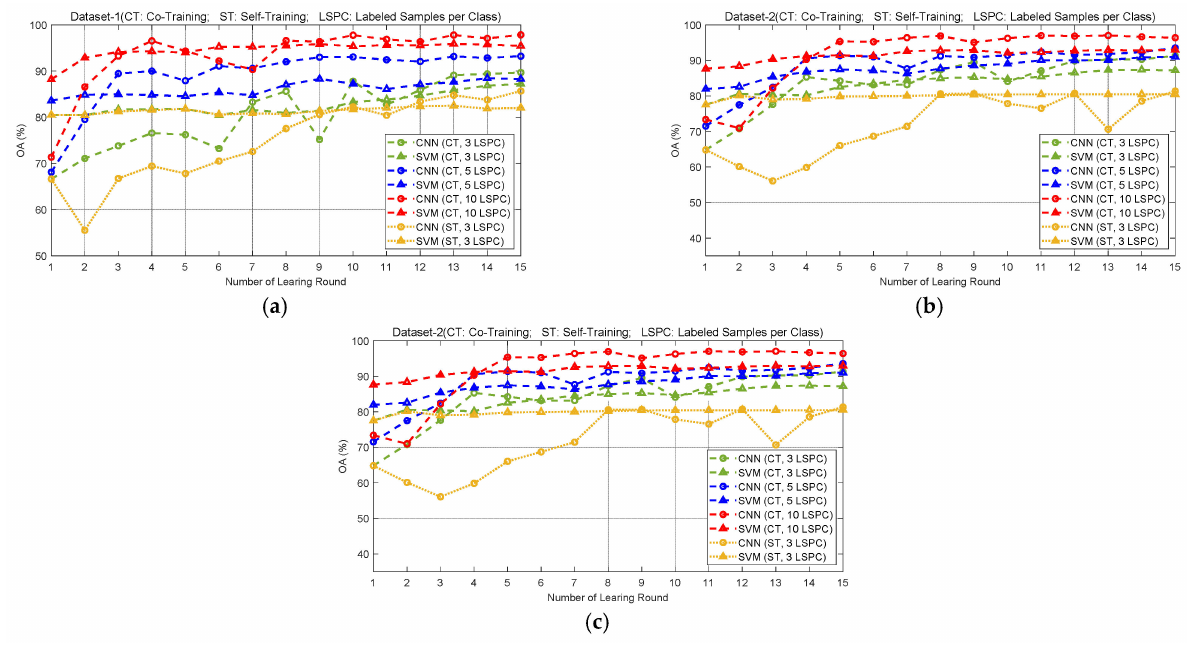
Figure 11. OA values obtained by SVM and CNN in different learning rounds of co-training and self-training methods applied to ( a ) dataset 1, ( b ) dataset 2 and ( c ) dataset 3, where “CT” denotes “Co-Training”, “ST” denotes “Self-Training” and “LSPC” denotes “Labeled Samples per